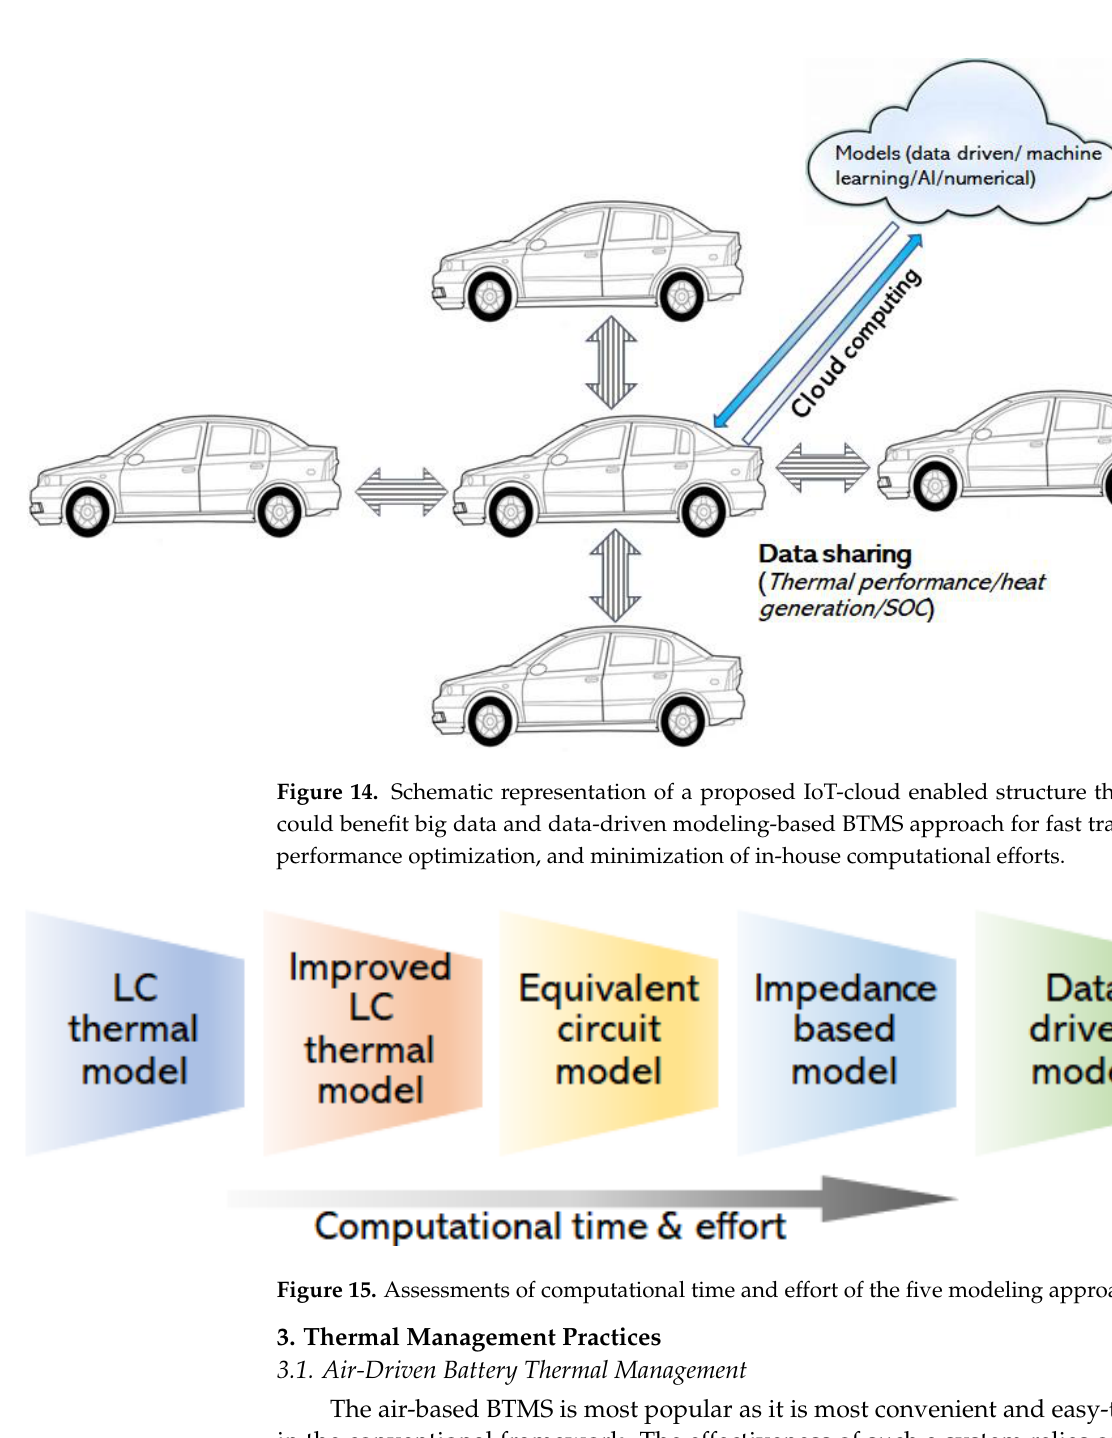
Figure 15. Assessments of computational time and effort of the five modeling approaches.